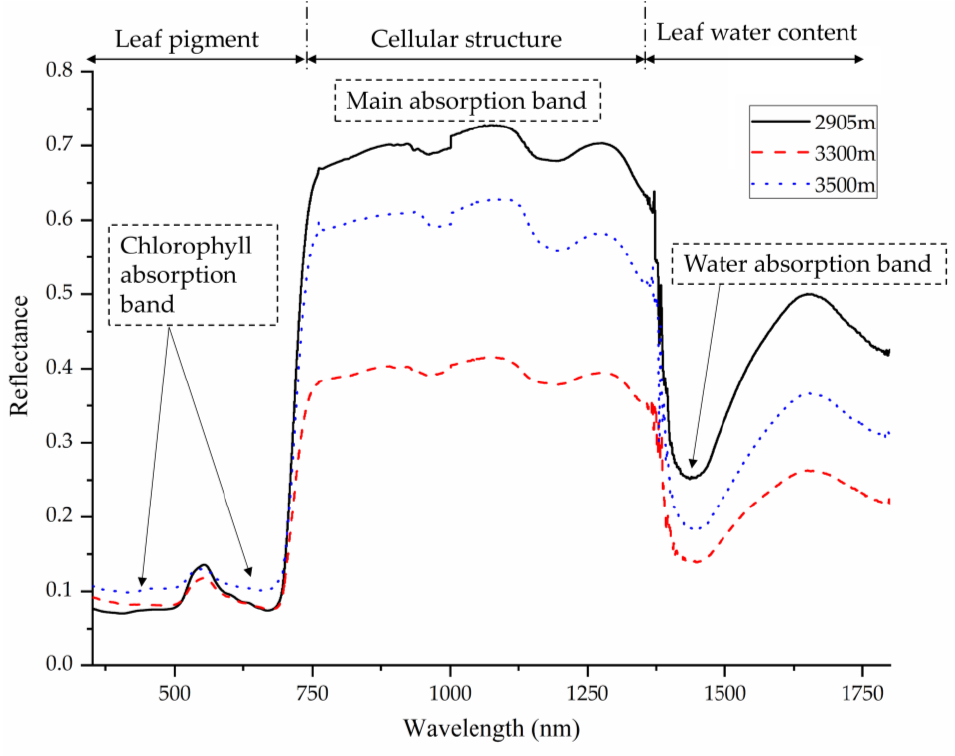
Figure 3. Reflectance spectral characteristics of Quercus aquifolioides leaves at different altitudes.